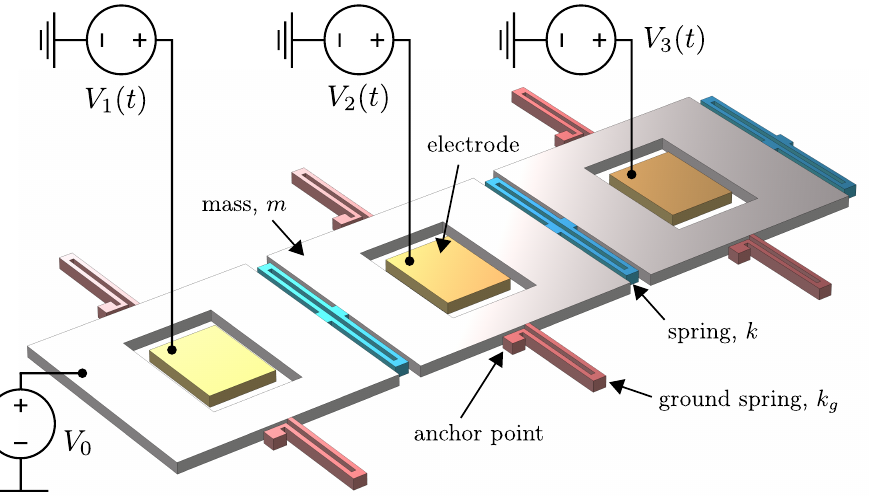
Figure 1. Unitary cell composed of three sub-cells. The masses (gray) are connected to each other through folded beams (blue) and to the ground (red). The electrodes (yellow) are fixed and placed in the hollowed masses. While the structure is set to a constant voltage V 0 , an alternate voltage V i ( t ) is imposed to each electrode i